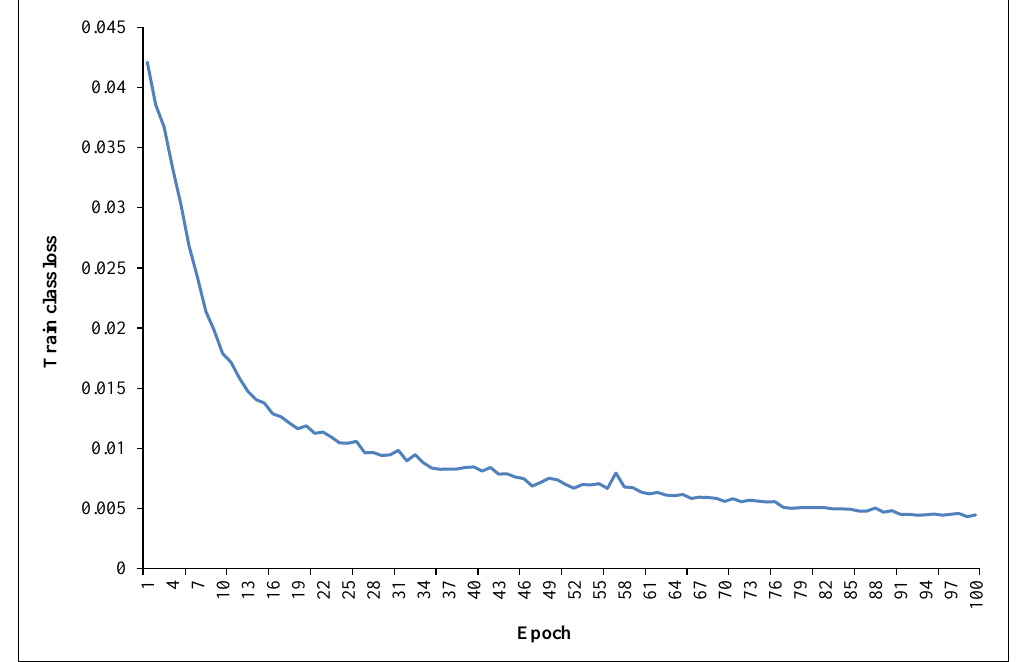
Figure 7. Yolov5s model training class loss vs epochs